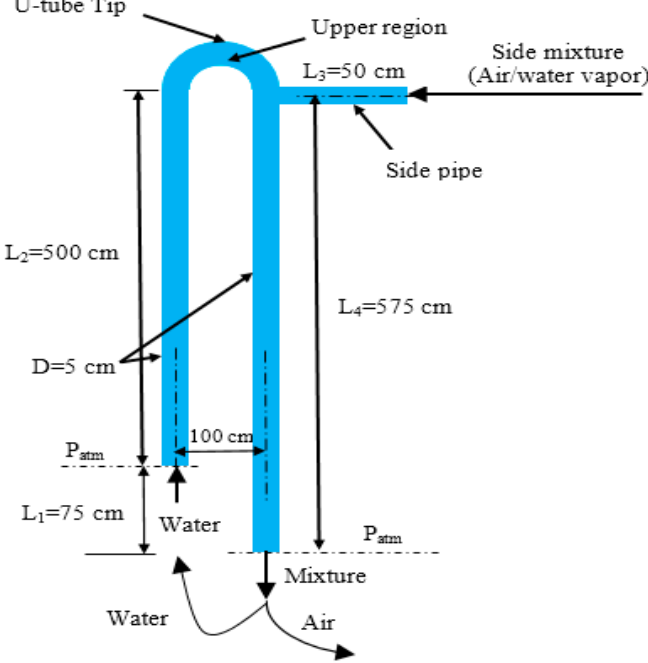
Figure 2. CFD model for the inverted U-tube with dimensions.